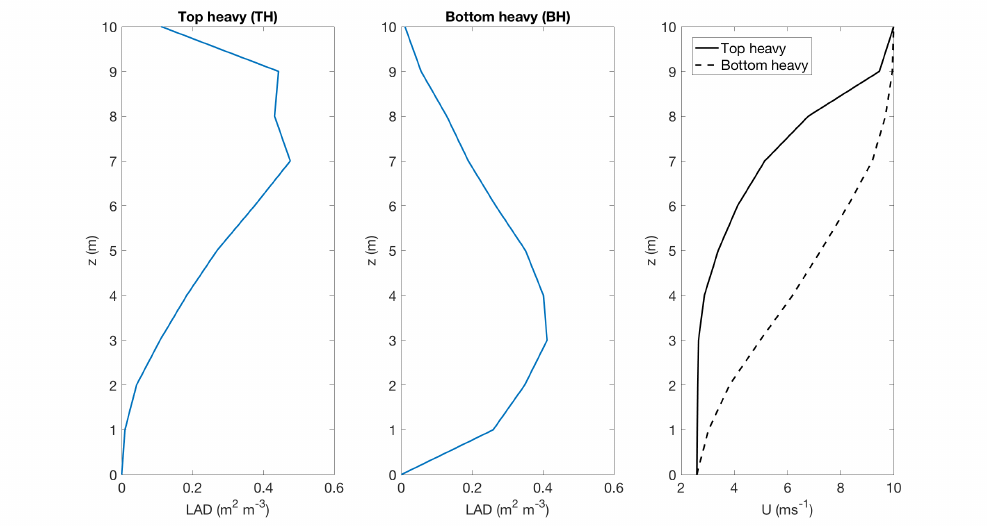
Figure 2. Two LAD distributions used in this study. The left panel shows the top heavy (TH) distribution and the right panel shows the bottom heavy (BH) distribution. Both TH and BH distributions, when integrated, yields the LAI of 2.7 m 3 m − 3 . The canopy height is 10 m. The third panel in Figure 2 shows the mean velocity profile obtained using Equation (15) for the top heavy and bottom heavy cases, for the canopy top wind speed of 10 ms − 1